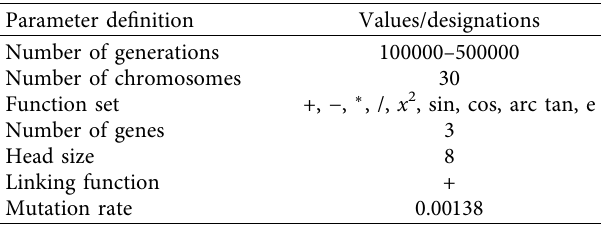
Table 5: The GEP algorithm parameters.